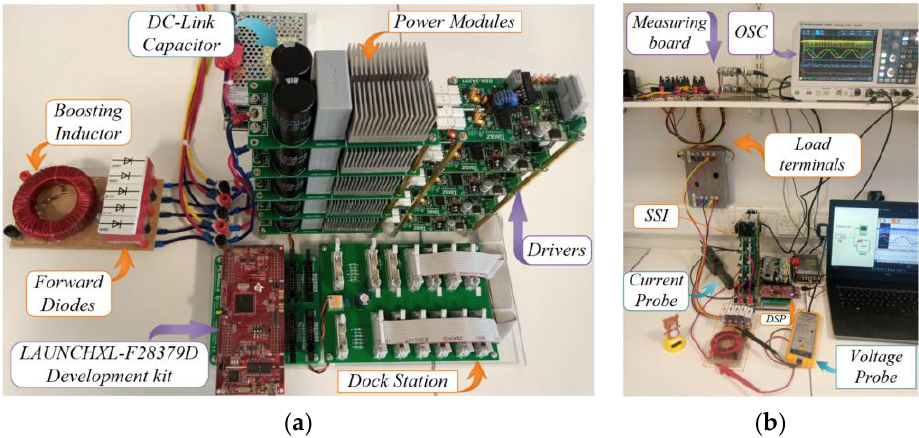
Figure 20. Photographs of the five-phase SSI prototype and experimental setup. ( a ) SSI. ( b ) Setup. The measured voltage and current waveforms are recorded via a multi-channel digital oscilloscope from ROHDE&SCHWARZ (R&S RTM3004) [28] and shown in Figures 21–23. The upper trace of Figure 21 shows the output voltage, output current, and supply current waveforms for the case study, while the lower trace shows a zoom of the measured waveforms. Moreover, Figure 22 shows the DC-link or capacitor-voltage waveform. In addition, the inductor voltage and the current stress on one of the forward diodes are shown in the upper trace of Figure 23; moreover, a zoom of the inductor voltage is shown in the down trace. Figure 21. Experimental waveforms of output-phase voltage, two adjacent phase currents, and the supply or inductor current for the proposed five-phase SSI with the modified space-vector modula- tion scheme.